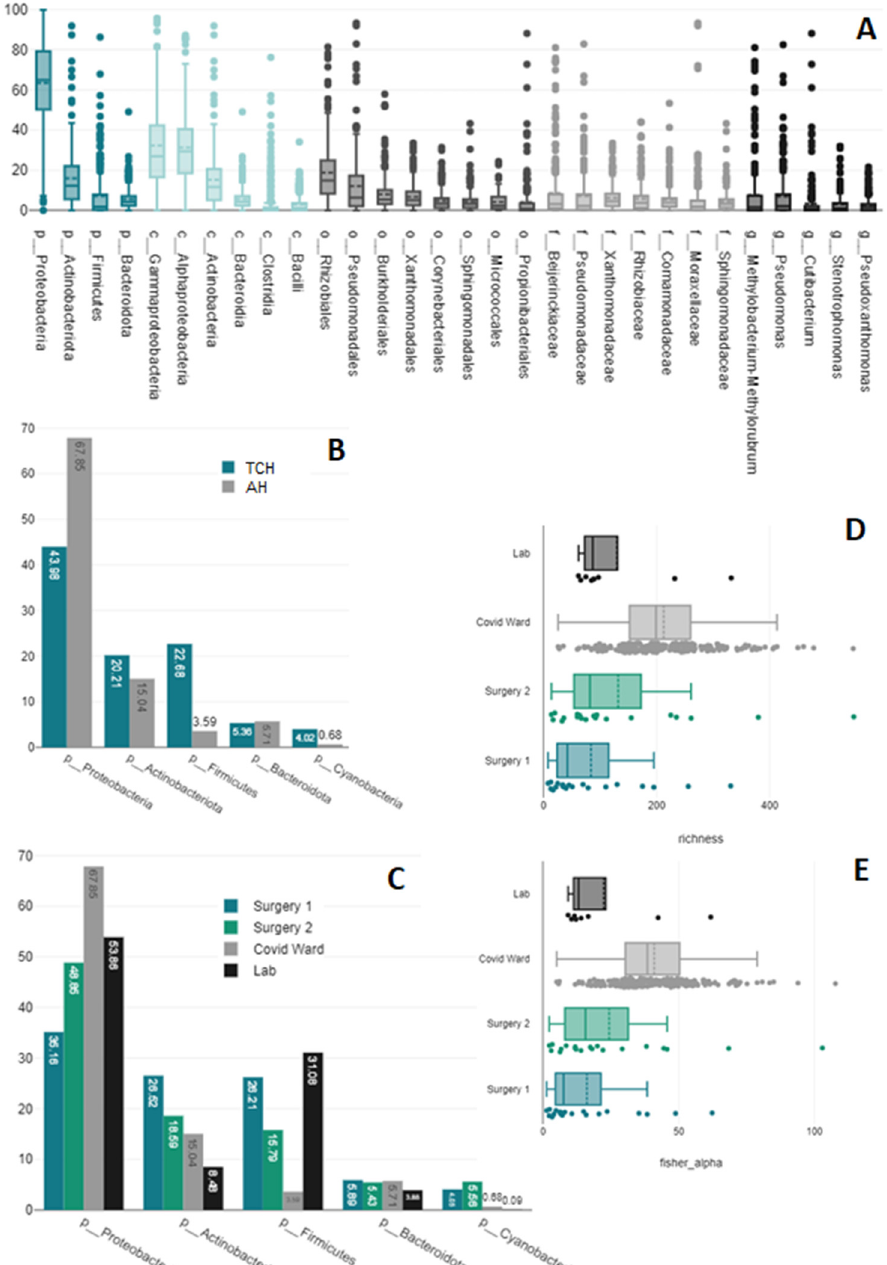
Figure 2. ( A ) Overall prevalence of the 30 most important taxa. Colors allow a more straightfor ‐ ward distinction between the different levels of taxonomic resolution. ( B ) Prevalence of the five most important phyla in the two hospitals and ( C ) institutes/wards. ( D ) Differences in richness and ( E ) Fisher ‐ alpha diversity across the different institutes/wards.